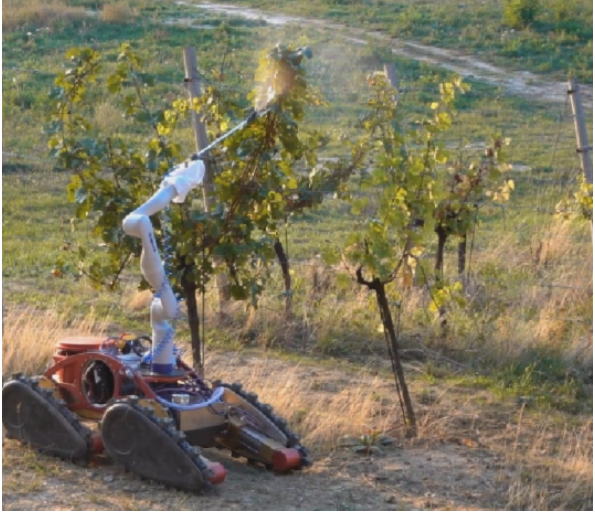
Figure 3. An ATMM in a vineyard spraying scenario. Spraying nozzle is attached to the robot arm, and the arm motion controls its pose relative to the mobile